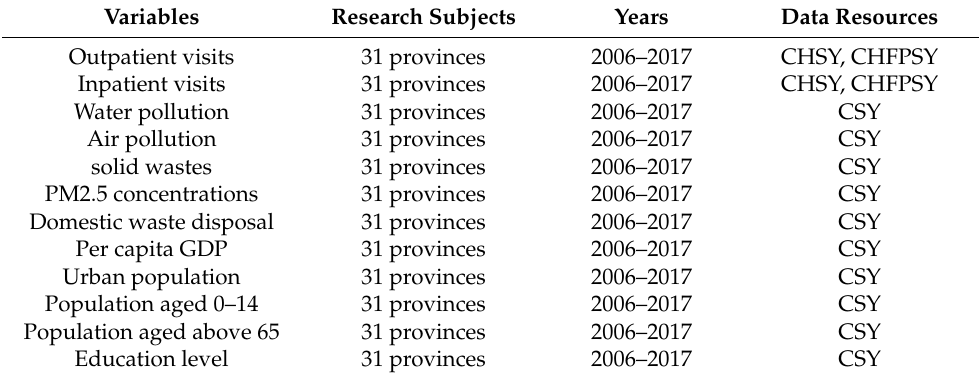
Table 1. Variables and data